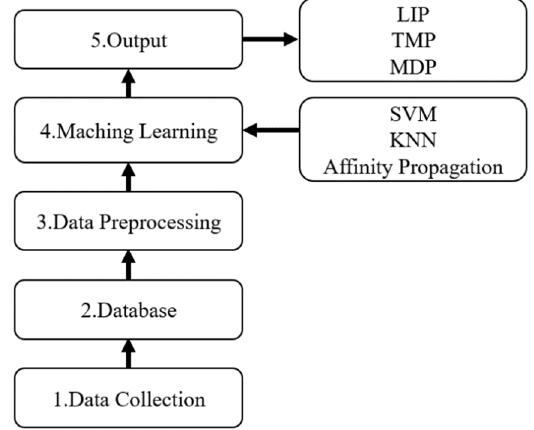
Figure 7. Framework for the collection of traffic data by the WST.